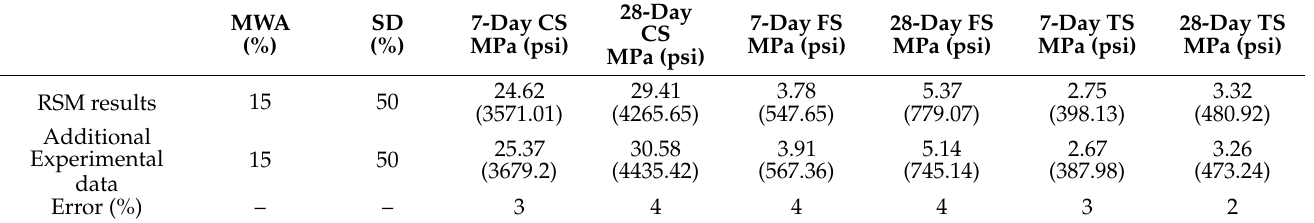
Table 10. Optimization of factor and experimental